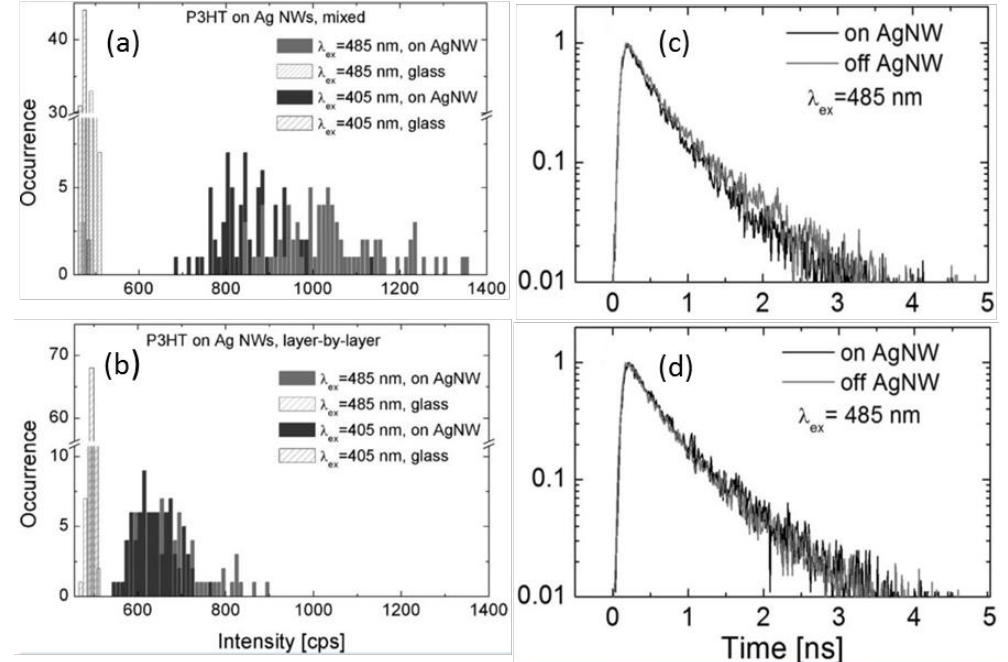
Figure 18. ( a ) Normalized fluorescence transients for samples where AgNWs were ( a ) mixed with PEDOT:PSS and ( b ) covered with PEDOT:PSS prior to deposition of the P3HT layer. Red curves correspond to data measured off the nanowires, while black curves represent data obtained with a laser spot placed at the nanowire. The excitation energy of 485 nm was used; ( c ) fluorescence intensities of P3HT on and off AgNW for the sample where AgNWs were mixed with PEDOT:PSS prior deposition of P3HT; ( d ) fluorescence intensities of P3HT on and off AgNW for the sample where PEDOT:PSS was deposited on AgNWs prior deposition of P3HT. In both cases, the results obtained for lasers excitations of 405 nm (blue bars) and 485 nm (red bars) are displayed [94]. Reprinted with permission from Ref. [94].